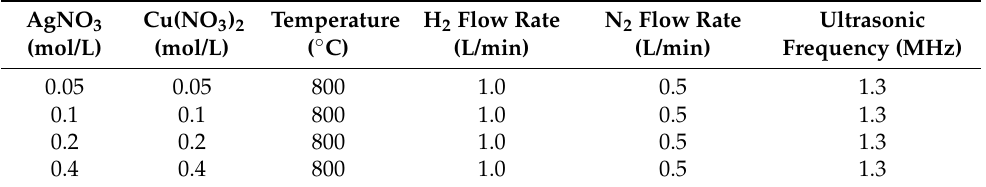
Table 1. Experimental parameters.